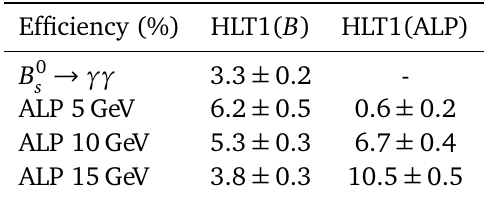
Table 2: Percentage efficiency relative to all candidates accepted by the Photon and Electron channels of the L0 hardware trigger for the B 0 all the γ reconstruction